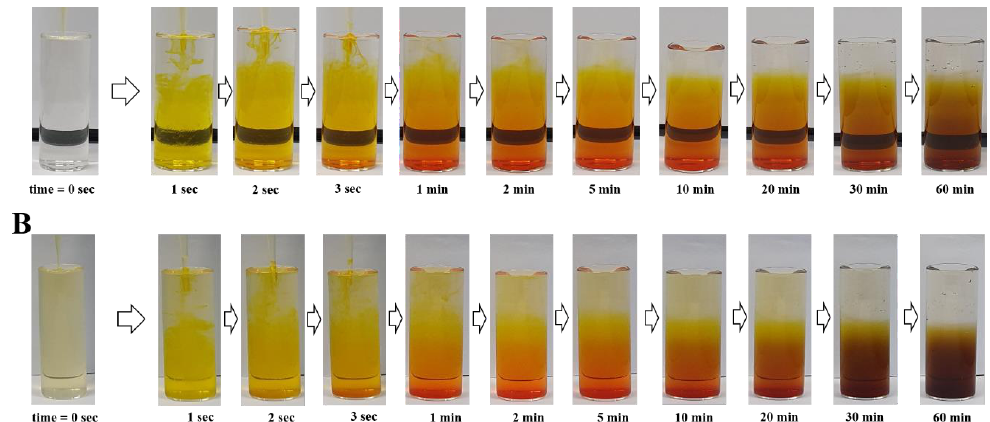
Figure 3. ( A ) Sequential time images of color change in the presence of Fe 2+ . The concentrations of hydrazine, H 2 O 2 , Fe 2+ , and p -dimethylaminobenzaldehyde are 0.025 M, 0.2 M, 32 ppm, and 4 × 10 −6 M, respectively. ( B ) Sequential time images of color change in the presence of Fe 3+ . The concentration of hydrazine, H 2 O 2 , and Fe 3+ , and p -dimethylaminobenzaldehyde are 0.025 M, 0.2 M, 32 ppm, and 4 × 10 −6 M, respectively.